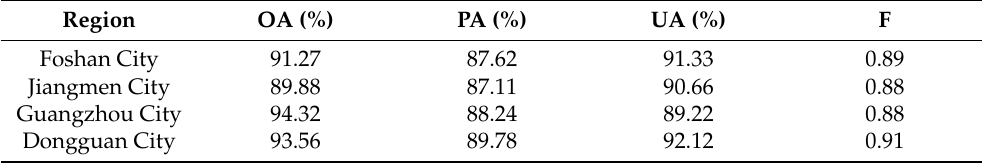
Table 4. BAs extraction accuracy of the four areas in Figure 10 using our method.